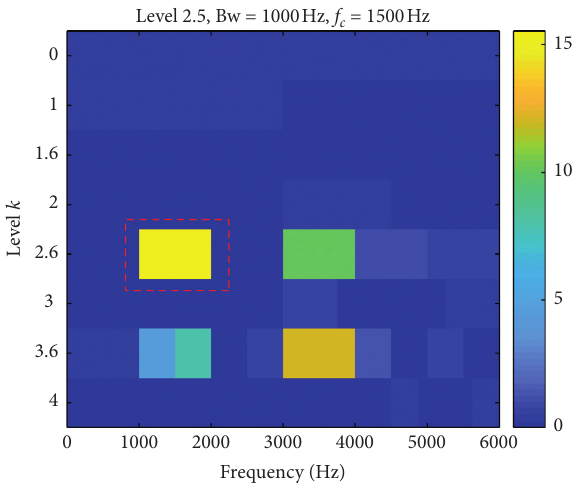
Figure 8: The colormap of the simulation signal via a fast computation of protrugram.